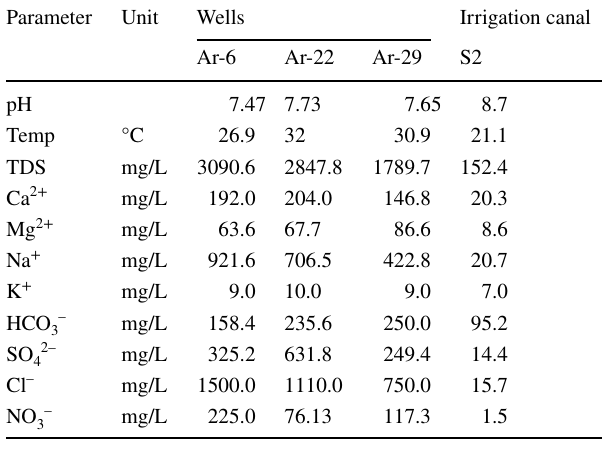
Table 8 Estimated daily intake (ADD) and hazard quotient (HQ) for adults and children in the study area